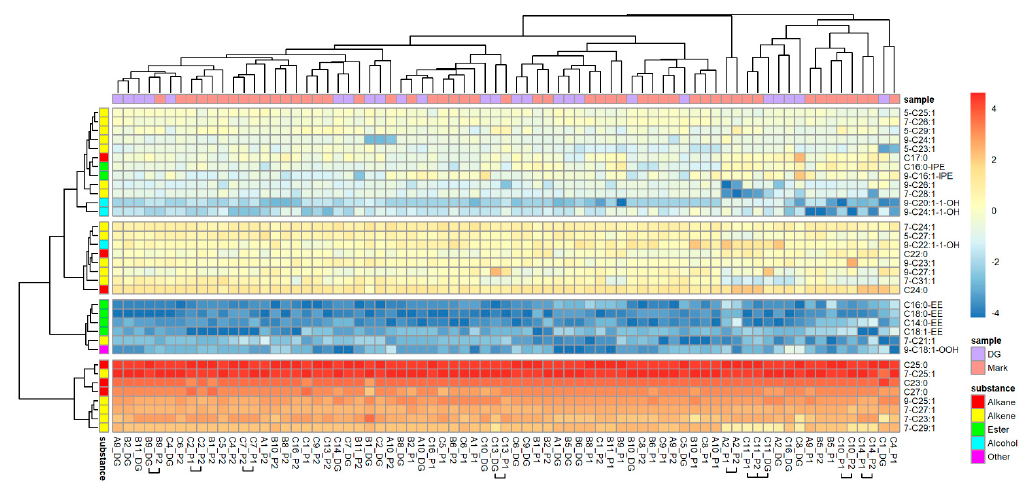
Figure 3. Composition of Dufour’s gland extracts and individual scent marks of O. cornuta nests (34 substances). Compounds